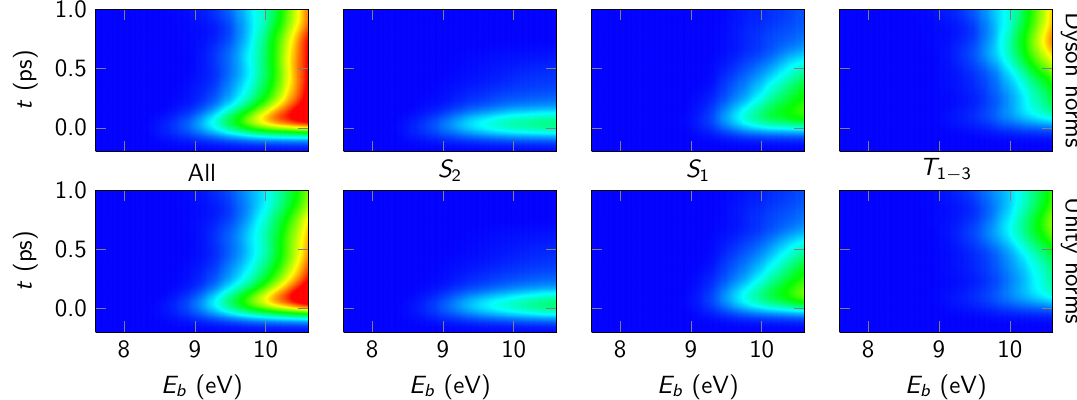
Figure 4. Simulated TRPE spectra of 2TU for the individual neutral states with temporal convolution (FWHM 190 fs). Each column of panels shows the spectral contribution of one initial (neutral) state ( S 2 , S 1 , T 1 3 ), with the total sum given in the first column. The top row was computed with Dyson − norms and rectangle line shape functions, the bottom row by setting all relevant Dyson norms to unity. As above, 4.2 eV pump energy and 6.4 eV probe energy were assumed in the computation of the binding energy. The color palette is the same as in Figure